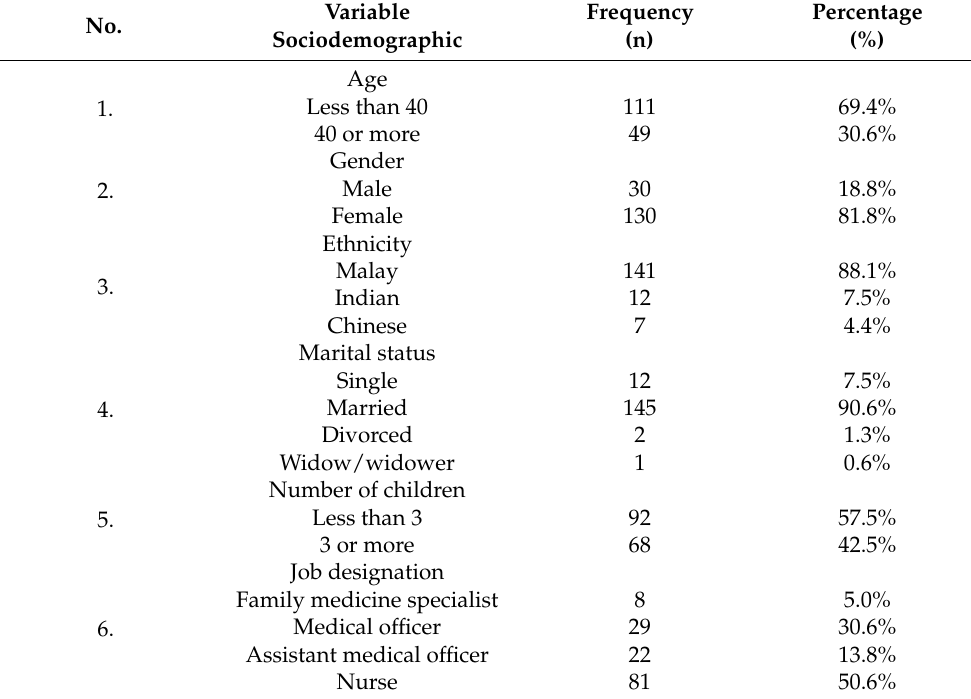
Table 2. Respondents’